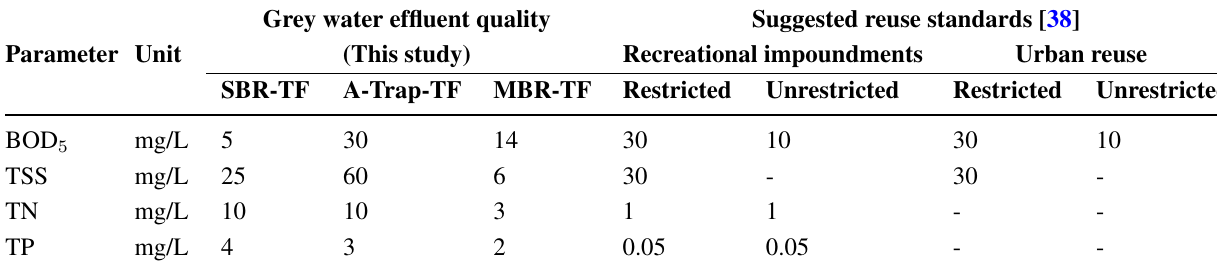
Table 4. Calculated effluent quality of grey water treatment systems and suggested standards for water